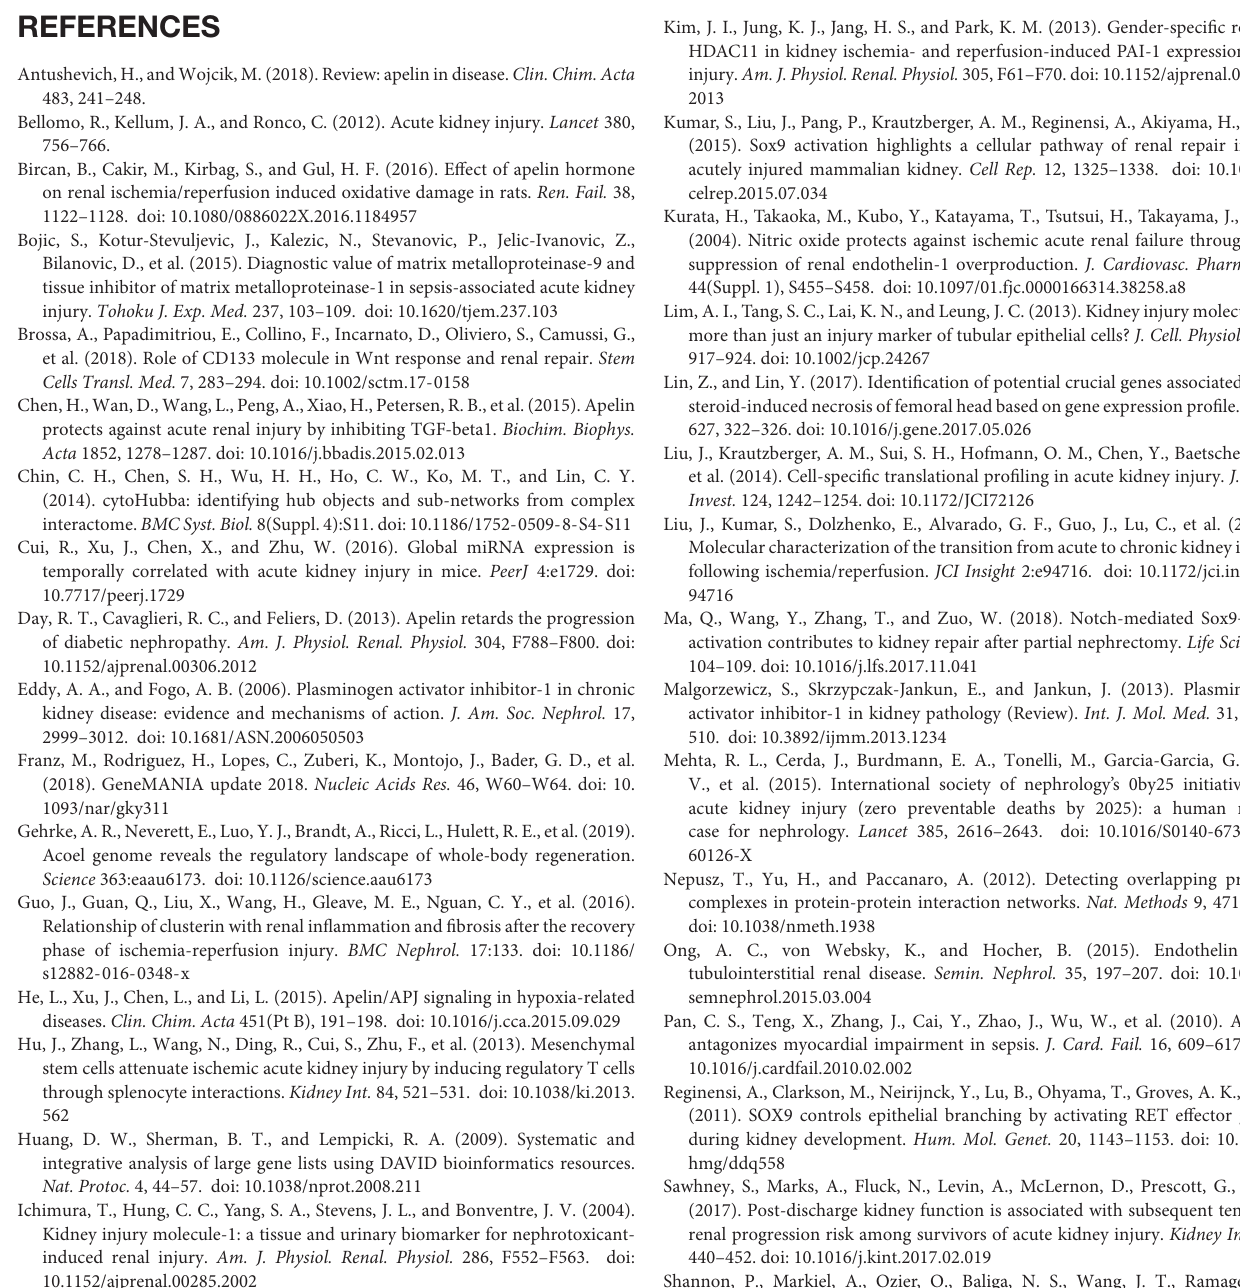
TABLE S2 | Genes that were differentially expressed in all four GroupSets in AKI by integrated analysis of high-throughputs. TABLE S3 | GO and KEGG enrichment analysis of genes that were differentially expressed in ≥ 3 GroupSets (top 6 significantly enriched terms were listed). TABLE S4 | The KEGG pathway of five significant modules selected by